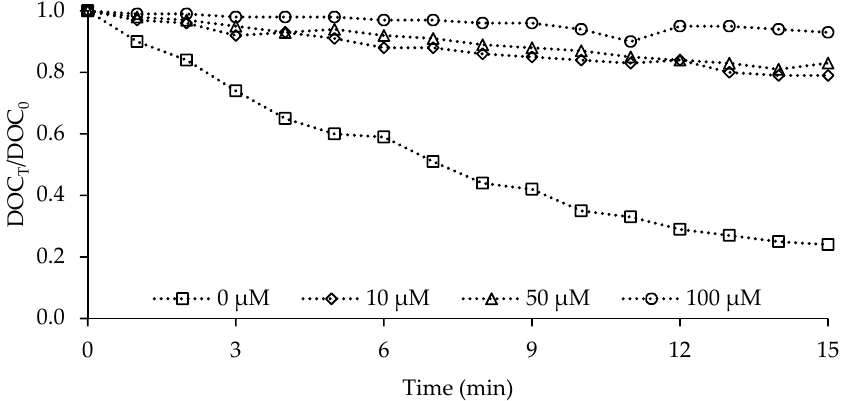
Figure 11. Effect of phosphate on the performance of catalytic ozonation.